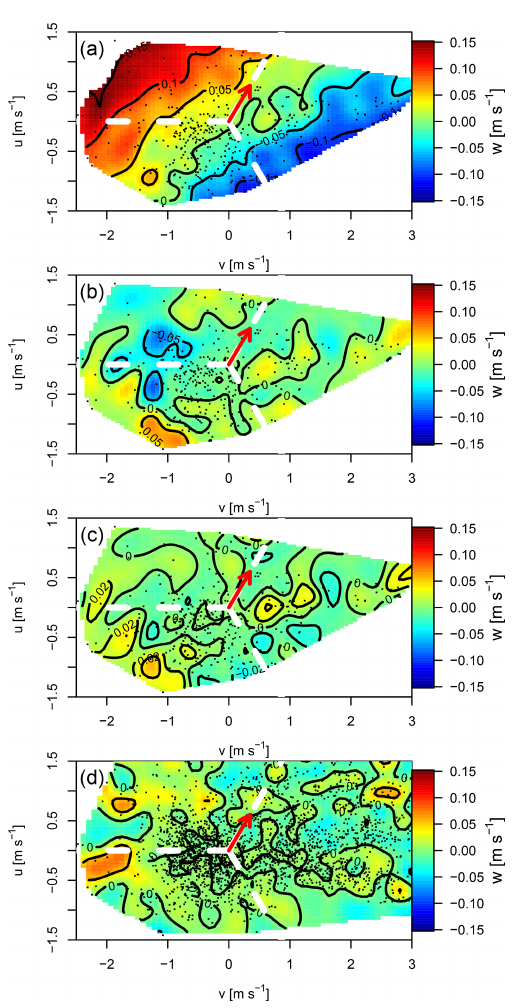
Figure 17. 30min mean vertical wind velocity w as a function of horizontal wind velocities u and v before and after planar fit coordi- nate rotation for two different planar fit procedures and two periods. Wind velocities were obtained by the Gill-R3 sonic anemometer which was used for true eddy accumulation. (a) Unrotated verti- cal wind velocity. (b) Rotated vertical wind velocity from real-time 1d moving window planar fit rotation performed by TEA system. (c) Rotated vertical wind velocity with single planar fit rotation pe- riod performed in post-processing. (d) Same as (c) but for a longer period, i.e., from 1 April to 31 May 2015. Panels (a) to (c) show data from the experimental period of the current study from 4 to 11 April 2015. Black dots indicate the location of individual 30min mean vertical wind velocity readings in the u – v velocity space. Red arrows indicate the direction to north. Dashed lines, in white, indi- cate the azimuth of the vertical stanchions of the sonic head struc- ture relative to the center of the sonic coordinate system.